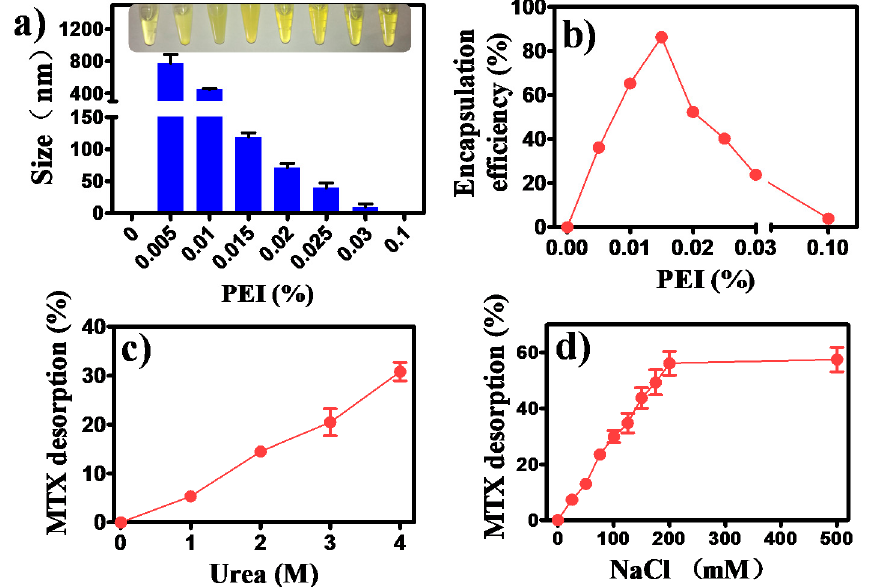
Figure 1. The formation of MTX/PEI NPs and mechanism understanding of the interaction be-tween MTX and PEI. ( a ) Appearance and dynamic light scattering (DLS) size of MTX/PEI mixture changed with PEI concentration. ( b ) MTX encapsulation efficiency changed with the increasing concentration of PEI. ( c, d ) MTX desorption rate increased with urea concentration and NaCl con-centration.